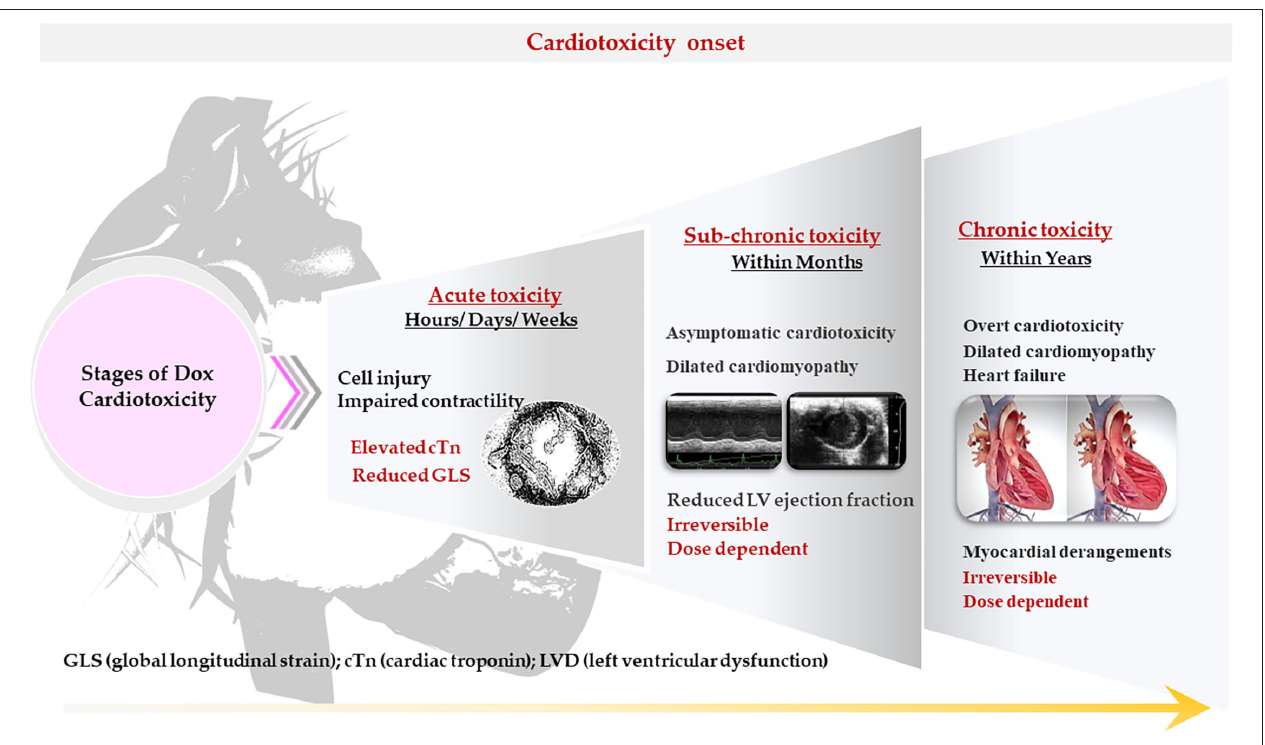
FIGURE 4 | Characteristics of doxorubicin (Dox)– induced cardiotoxicity. The cardiotoxicity in cancer patients is classified according to the time of onset, severity, and characteristics. It may manifest as either acute, sub-chronic (early onset) or chronic (late